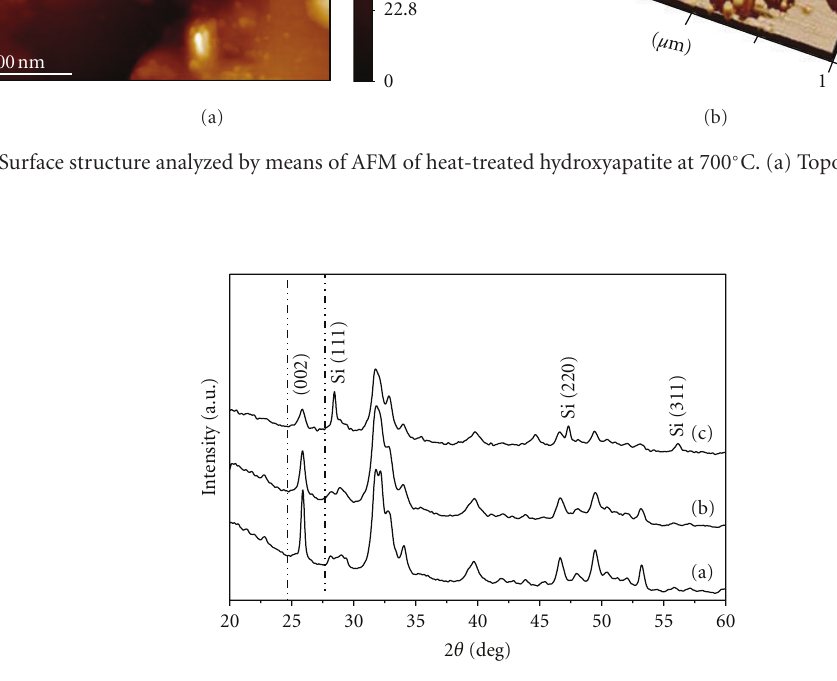
Figure 13: XRD patterns of (a) hydroxyapatite powder, (b) milled hydroxyapatite, and (c) mechanical alloying Si-doped